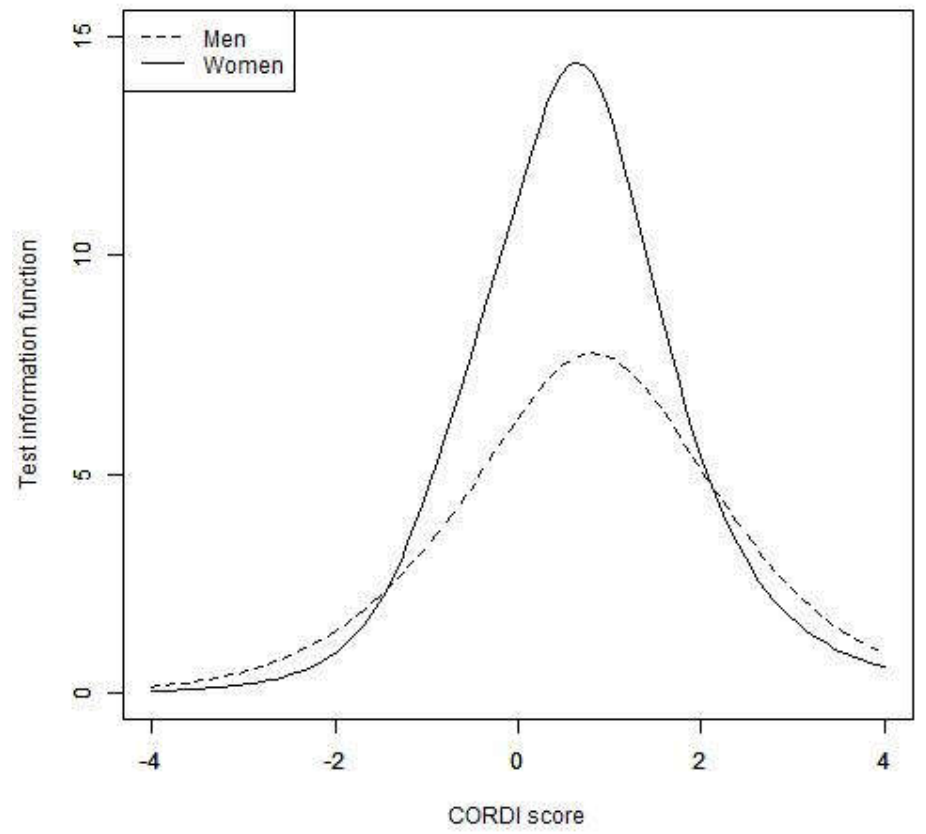
Figure 2. Test information functions of the CORDI item set of men and women. The polyserial correlation coefficient with COVID-19-related stress was 0.47 ( P < 0.05) validity of the CORDI